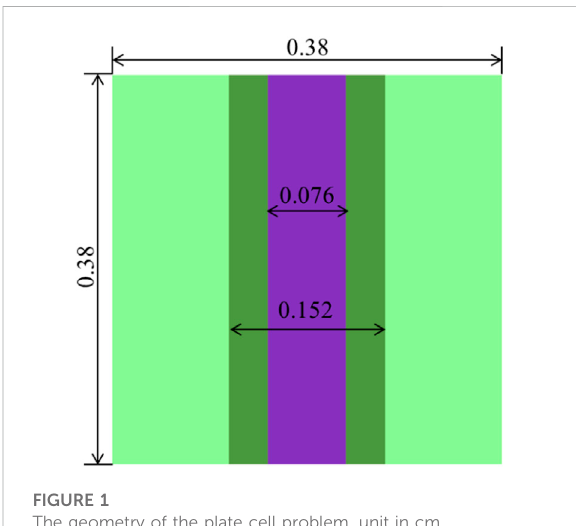
FIGURE 1 The geometry of the plate cell problem, unit in